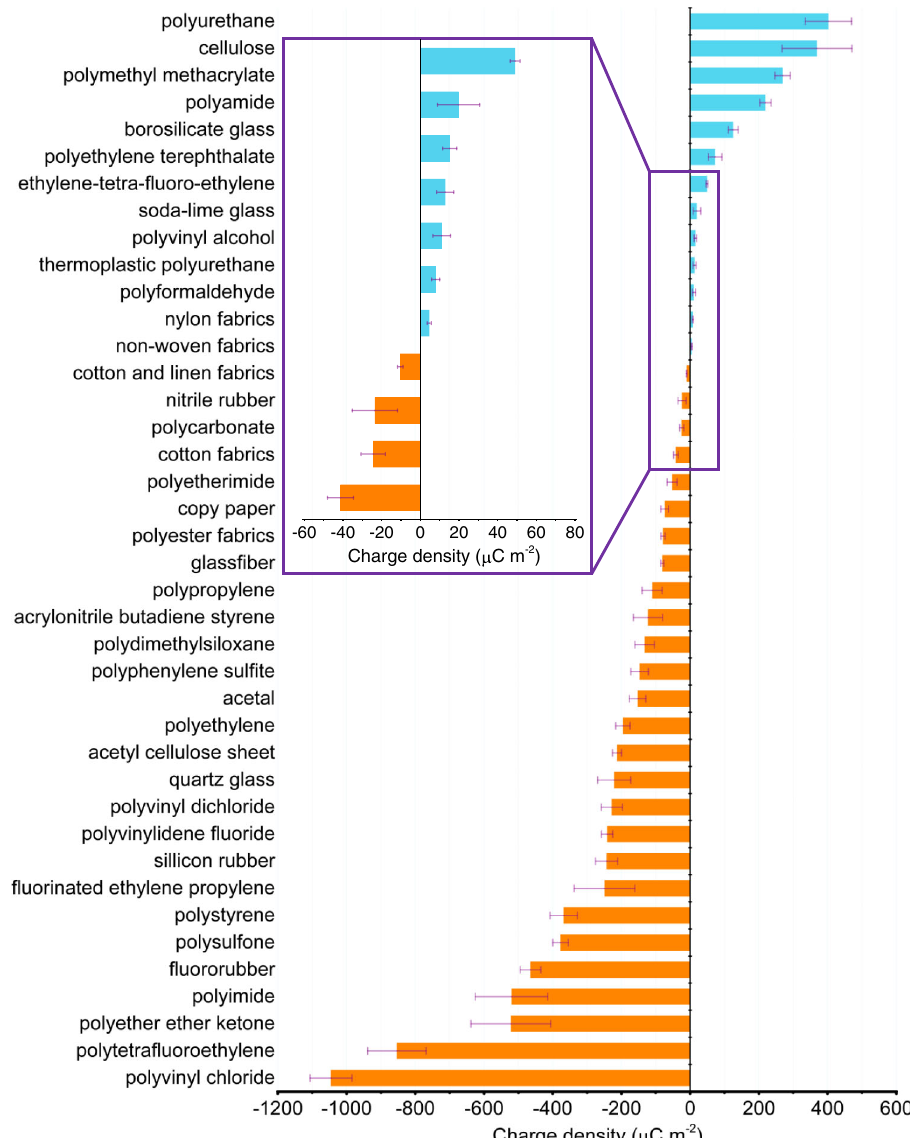
Fig. 3 | TECD of various materials in vacuum condition. Error bars represent standard deviation, n =5 independent samples. Source data are provided as a Source data fi